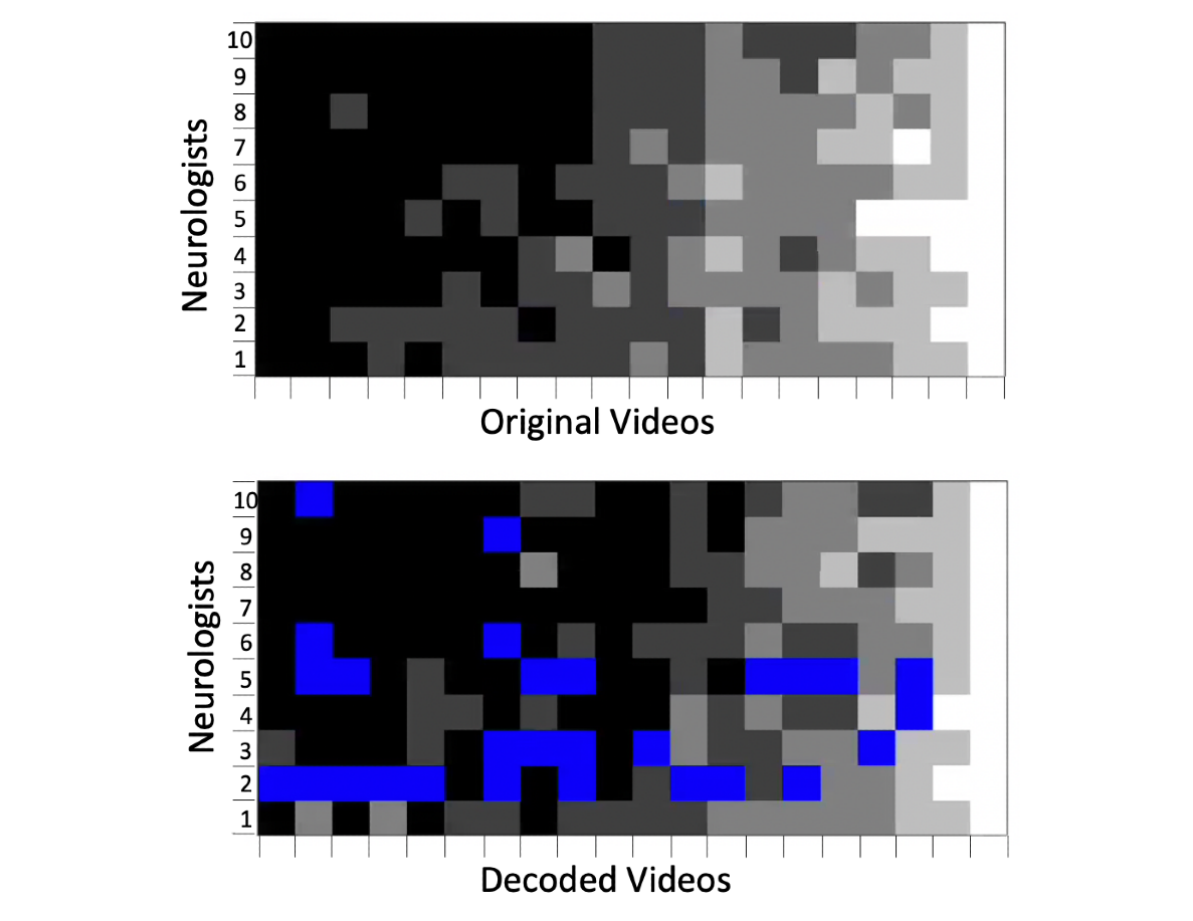
Figure 2. Ratings by 10 neurologists of the original and decoded videos. The colored squares represent the different grades for limb ataxia of the finger-to-nose-test according to the Neurostatus-Expanded Disability Status Scale subscores: black=0, dark grey=1, grey=2, bright grey=3, and white=4. The blue squares represent videos that were judged as not ratable by the